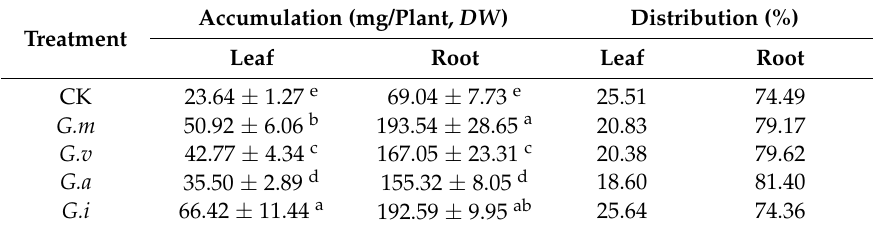
Table 8. Effects of AMFs on salvianolic acid B accumulation of S. miltiorrhiza seedling roots. Accumulation (mg/Plant, DW ) Distribution (%) Treatment Leaf Root